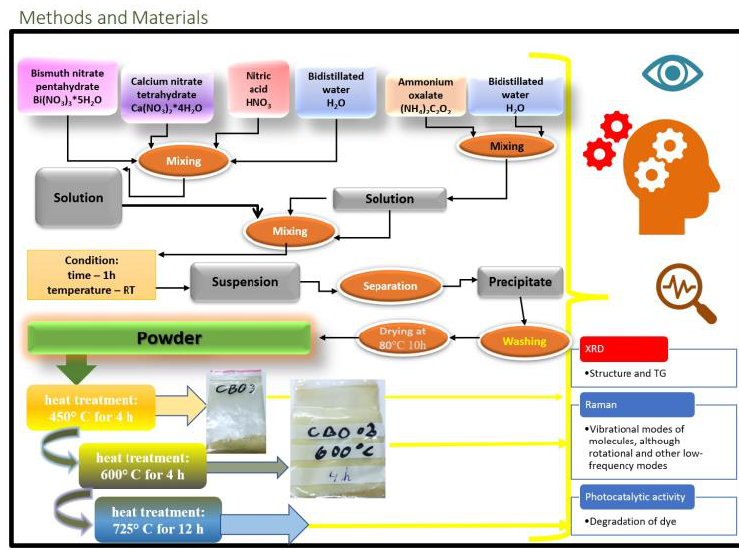
Figure 11. Schematic representation of obtaining and characterization of CBO system.